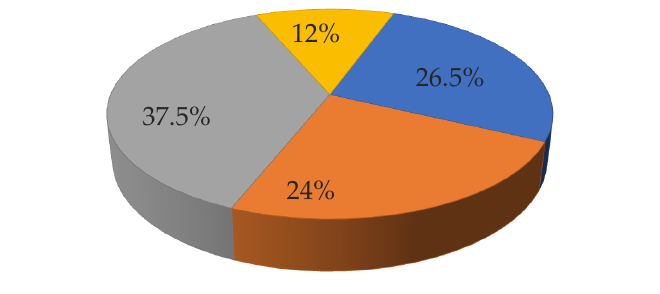
Figure 25. Power loss distribution in the suggested converter at P O = 375 W.